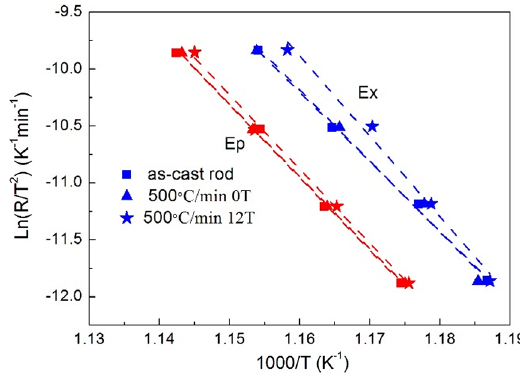
Figure 1. DSC traces for the Fe for 1h at different states at the heating rate of 20 °C/min.